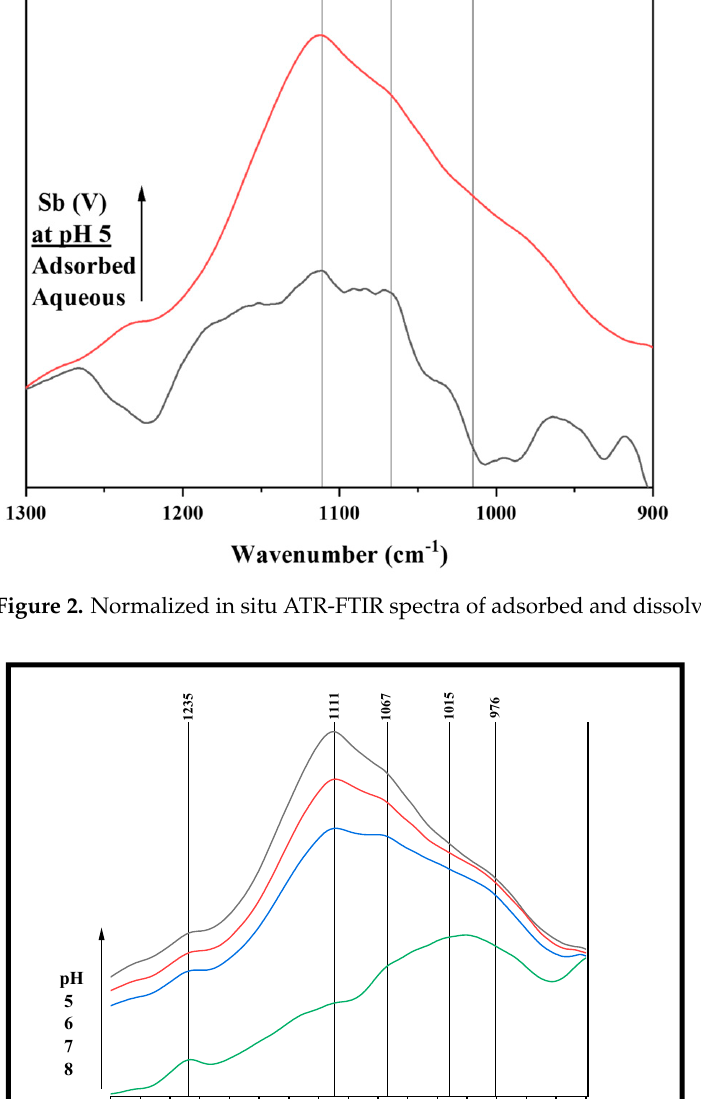
Figure 1. The in situ ATR-FTIR spectra of adsorbed and dissolved Sb (V) were stacked at each pH value. The intensity scale is drawn on actual scale obtained in the experiment.